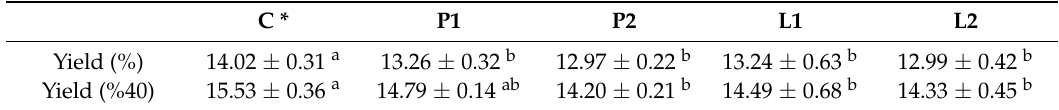
Table 2. Yield rates of White cheeses ( n = 3).